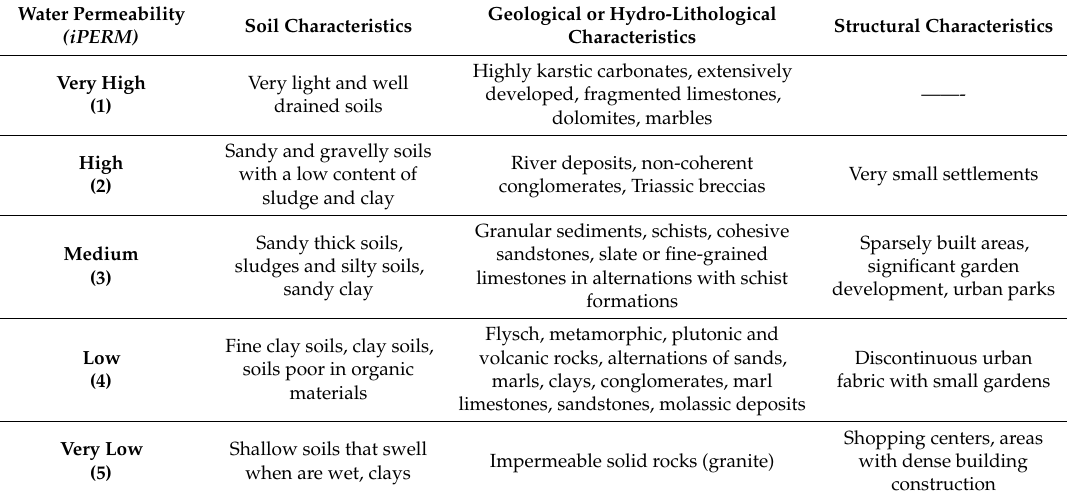
Table 3. Water permeability (iPERM) classes based on the soil and geological characteristics of the basin and the dominant type of construction.